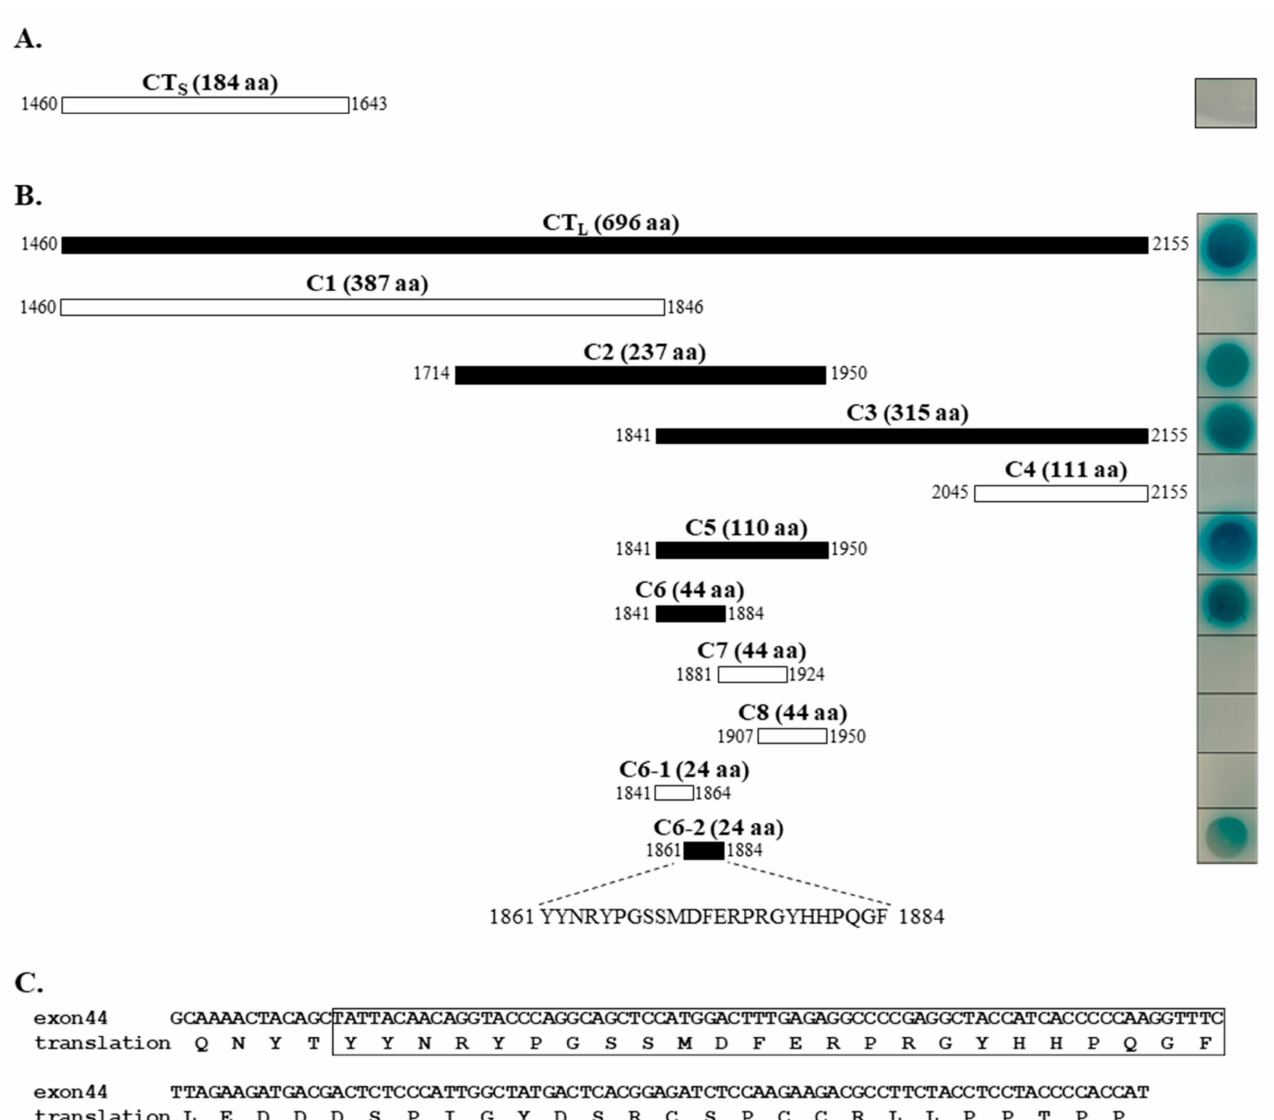
Figure 5. Identification of a Snapin2 interaction site in Ca v 1.3 CT tails using Y2H assays. ( A ) No interaction of the CT S of rat Ca v 1.3 S with Snapin2, based on Y2H assays. The CTs of rat Ca v 1.3 S are shown schematically as a white box with amino acid numbers and size. No blue colony was formed by Y2H assay (right). ( B ) Localization of a Snapin2 association site in the CT L of Ca v 1.3 L . The CT L of Ca v 1.3 L is shown as a black box representing its association with Snapin2. The CT L (1460–2155) was divided into C1 to C4. The overlapped region between C2 and C3 was designated as C5 (1841–1950), which was subsequently dissected into C6 to C8. C6 was finally divided into C6-1 and C6-2. C6-2 (YYNRYPGSSMDFERPRGYHHPQGF) was localized to interact with Snapin2. Blue colonies grown in a stringent condition (lacking Ade, His, Leu, and Trp) treated with X-gal were exhibited in the right side of the diagram. ( C ) Sequence information of C6-2 and exon44. The amino acid sequence of C6-2 marked as a box belongs to the deduced sequence of